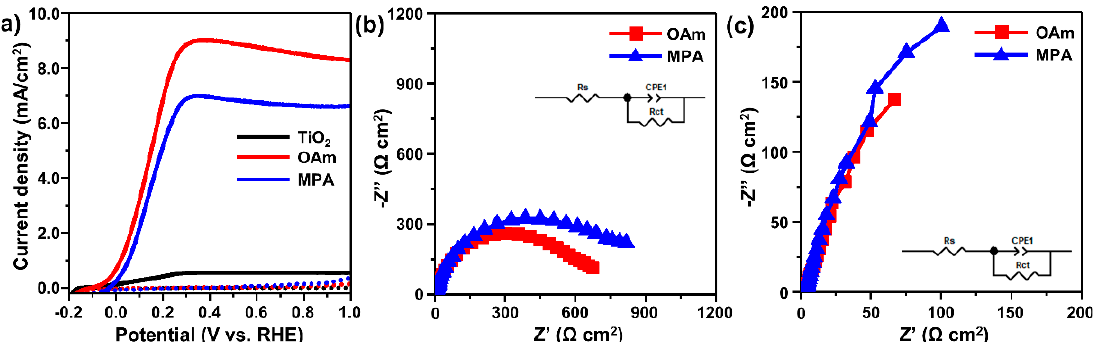
Figure 4. ( a ) J - V curves of an OAm-QD-photoanode, MPA-QD-photoanode, and TiO 2 control under continuous one sun illumination (solid lines) and in the dark (dashed lines). Nyquist plots of TiO 2 – CISe QD photoanodes ( b ) in the dark and ( c ) under one sun illumination. The insets show the equivalent circuit model.